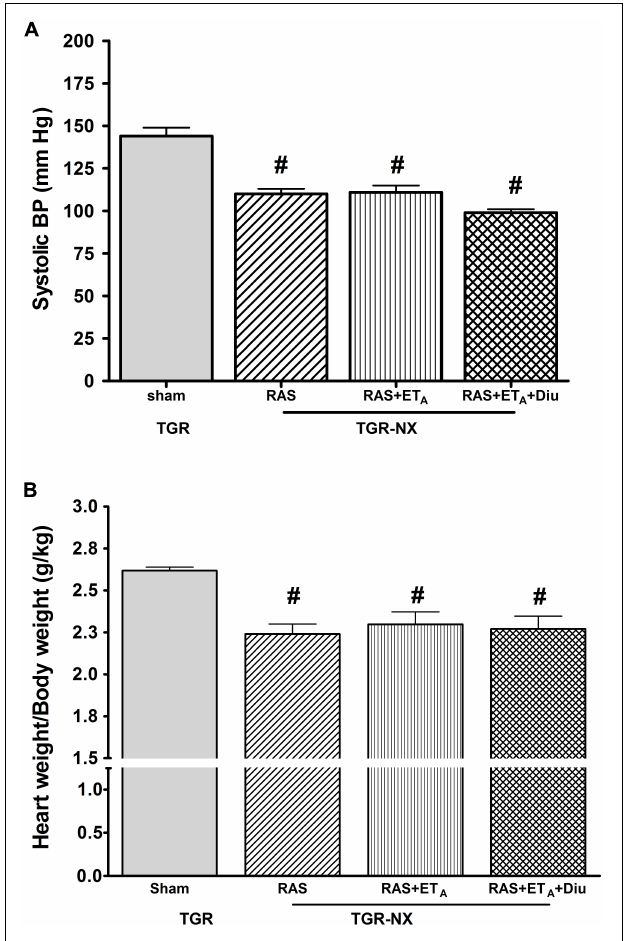
FIGURE 2 | The effect of diuretic treatment added to combined RAS and ET A blockade on SBP and cardiac hypertrophy. Systolic blood pressure (A) and cardiac hypertrophy (B) in sham-operated heterozygous Ren-2 transgenic rats (TGR-sham), nephrectomized TGR (TGR-NX) treated with the renin-angiotensin system blockade alone (RAS), combined RAS + ET A blockade (RAS + ET A ); or diuretic given with the combined RAS + ET A blockade (RAS + ET A + Diu). # P < 0.05 TGR-sham vs. other TGR-NX-treated groups, Diu – diuretic.